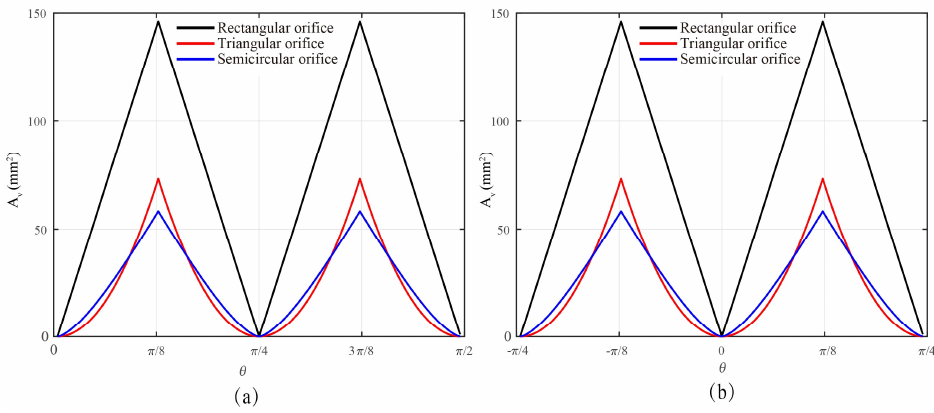
Figure 3. Orifice flow areas: ( a ) in θ ∈ [ 0,4 α ] , ( b ) in θ ∈ [ − 2 α ,2 α ] .